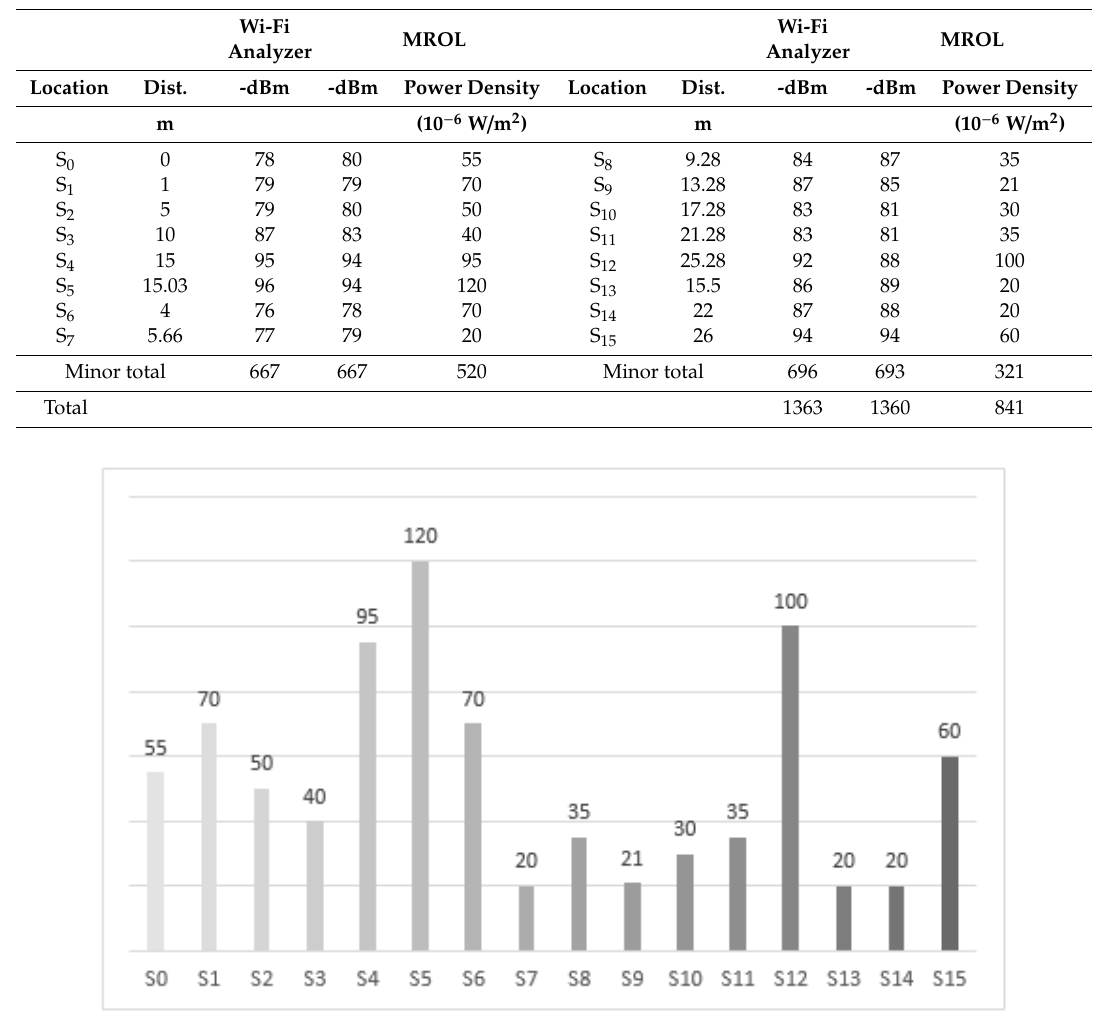
Wi-Fi MROL Analyzer